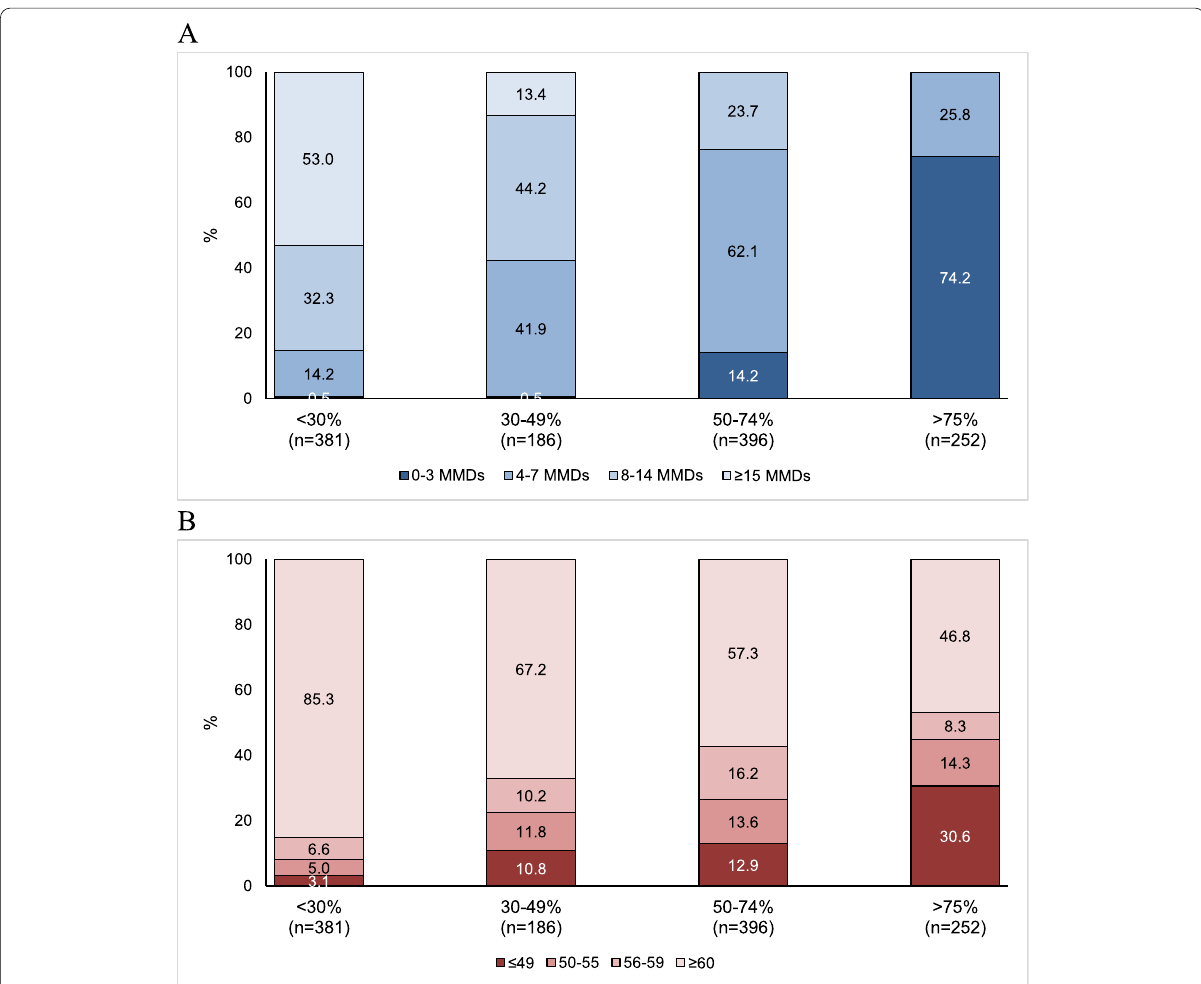
Fig. 3 Residual monthly migraine days ( A ) and Headache Impact Test-6 score ( B ) at weeks 9-12 according to erenumab response